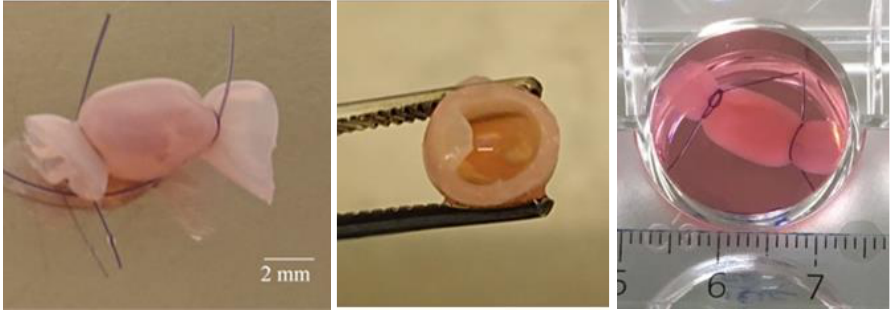
Figure 1. Chitosan bioreactor. From left to right: bioreactor containing ovarian tissue and tied at each end with suture thread; cross-section of the bioreactor showing the inner cavity and wall; culture well with bioreactor in culture medium.